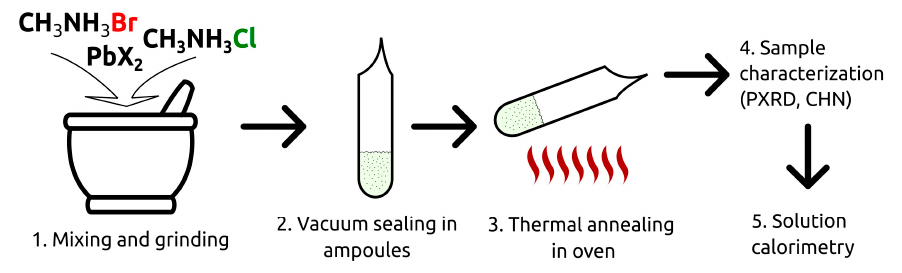
Figure 1. The schematic representation of the solid solutions synthesis process. The phase purity of all the prepared powders (binary halides and perovskite solid solutions) was analyzed by the powder X-ray diffraction (PXRD). The PXRD data were collected at T = (298 ± 3) K (expanded uncertainty, level of confidence 95%) using an Inel Equinox 3000 (Inel SAS, Artenay, France) diffractometer with Cu K α radiation in the 2 Θ range from 10° to 90°.